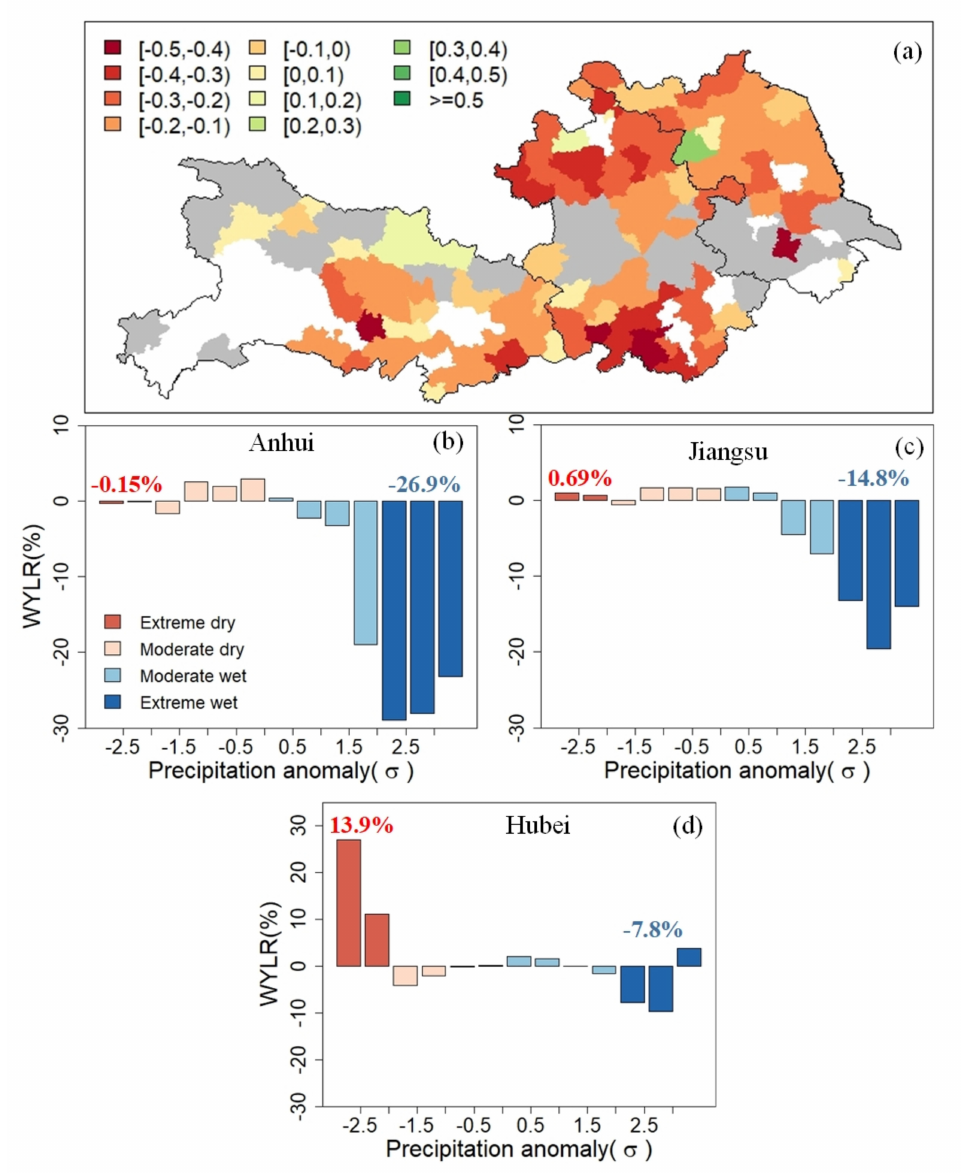
Figure 6. The impacts of extreme wet on winter wheat yield at the county level ( a ) and the impact of extreme precipitation on winter wheat yield in Anhui ( b ), Jiangsu ( c ) and Hubei ( d ) province. The excessive rainfall impact for each county is the WYLR of extreme wet years for each county. The counties with gray color means there is no extreme wet or dry